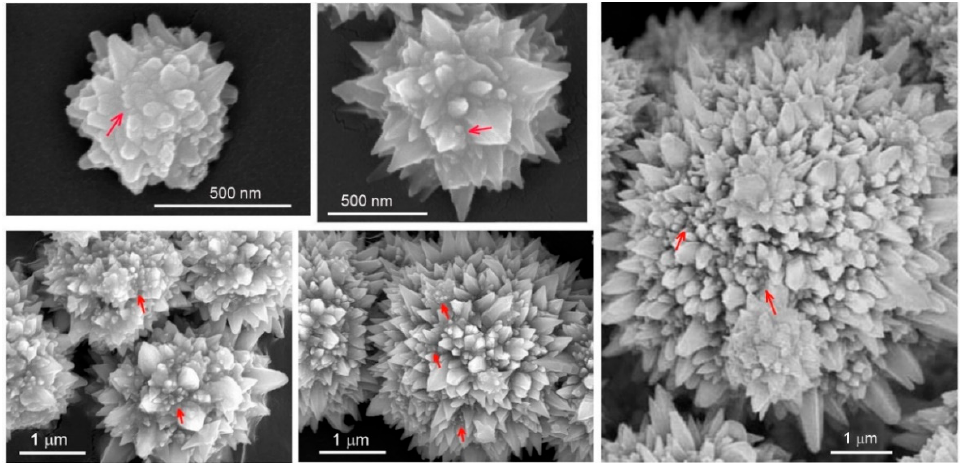
Figure 11. SEM image of the nanohorn-containing spheres of different sizes found in the products in a 200 mL NaOH solution (15 M) containing 3 mL of EDA.